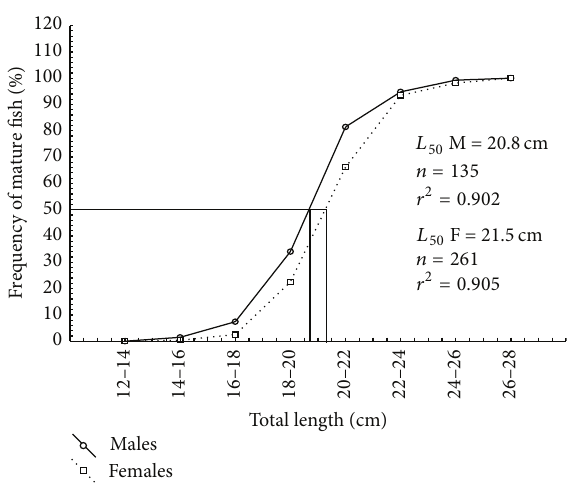
Figure 3: The cumulative percentage of observed mature fish in relation to body size for males and females of H. brasiliensis . The inserted lines represent the estimated size range where 50% of the fish were